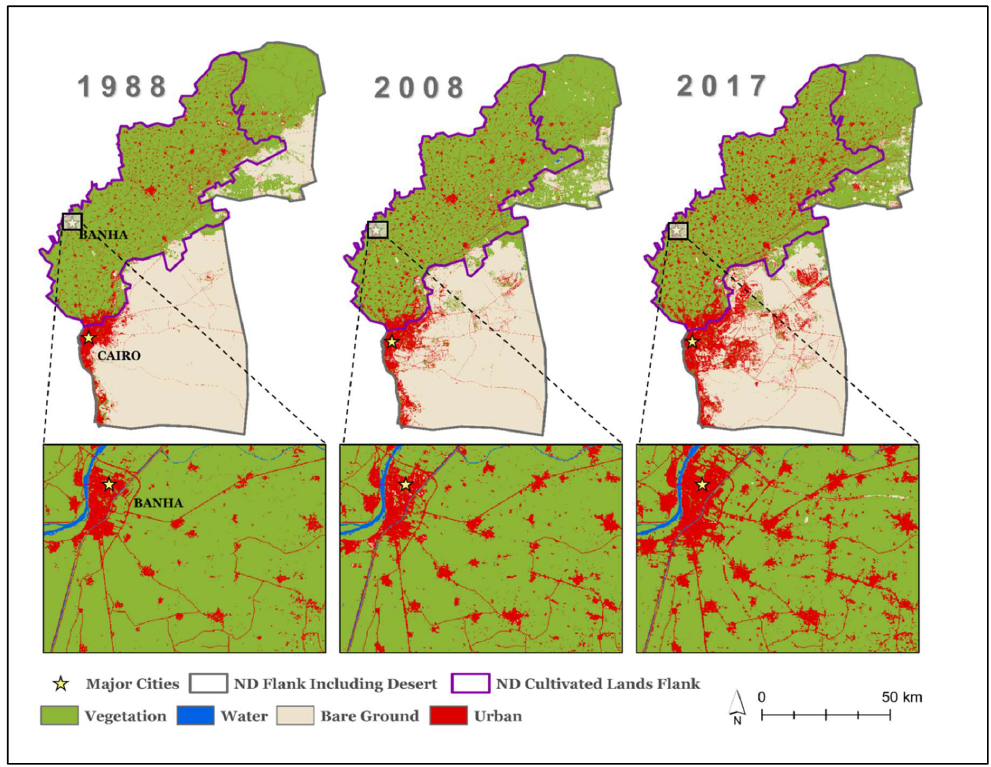
Figure 4. Land-use and land-cover (LULC) hybrid classifications for 1988, 2008, and